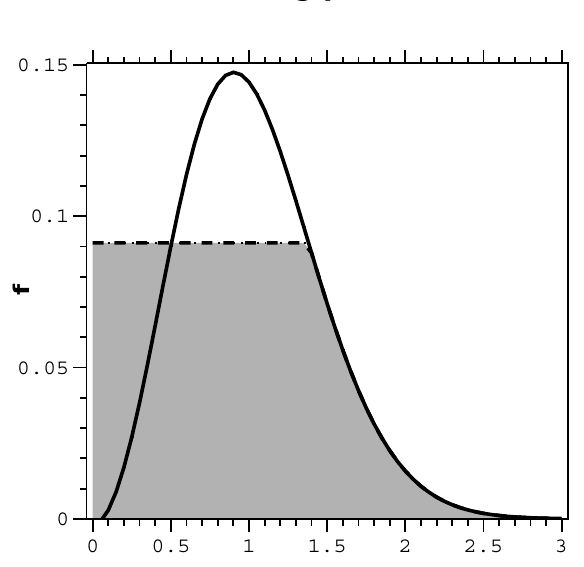
Fig. 1. Example shell distribution generated by the expression f (v) = exp ( − v 2 ) − 1 . 00206exp ( − 1 . 5 v 2 ) . The velocity and the distribution function are in arbitrary units. The shaded region de- limited by dotted line is the closest equilibrium distribution defined in the text. The free energy is 6.9% of the total kinetic energy in this